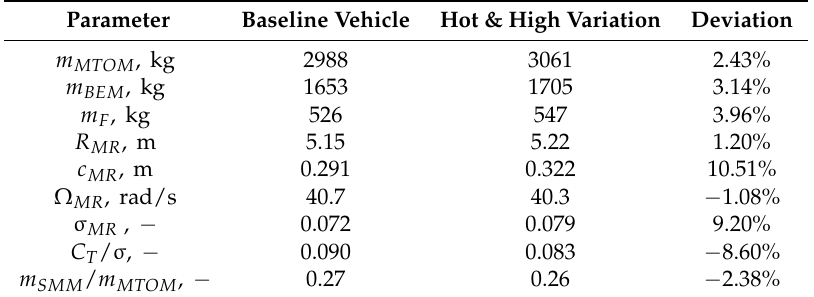
Table 9. Variation of the rotor design parameters for hot and high performance